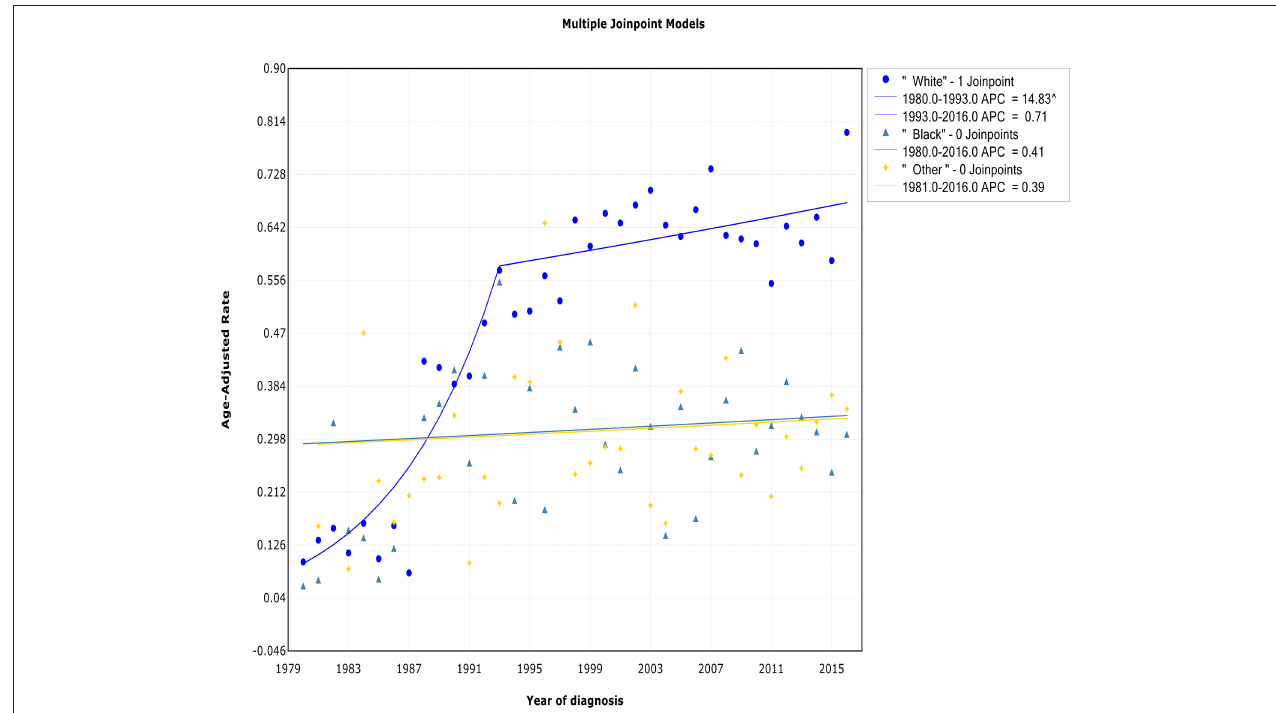
FIGURE 7 | Trends in the annual incidence of Waldenström macroglobulinemia in patients stratified according to race.